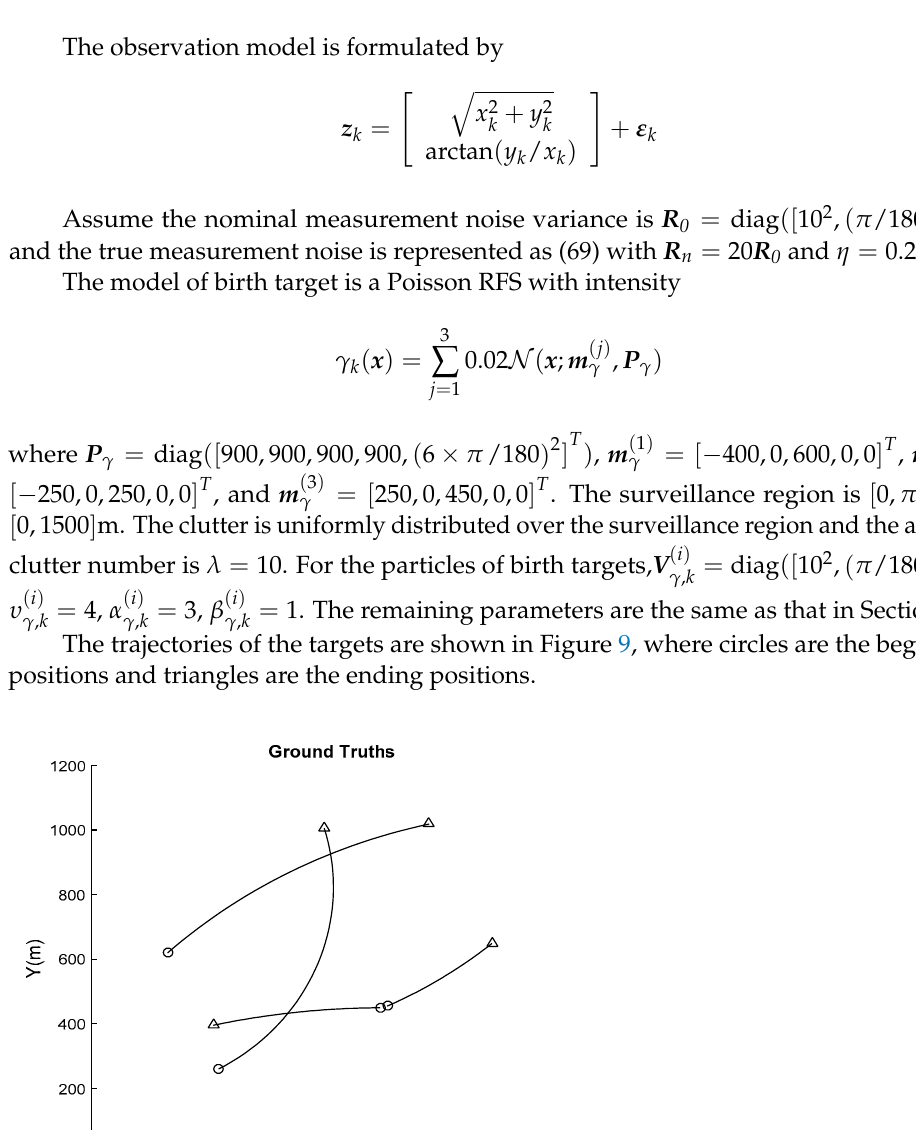
Figure 10. The estimate of target number.